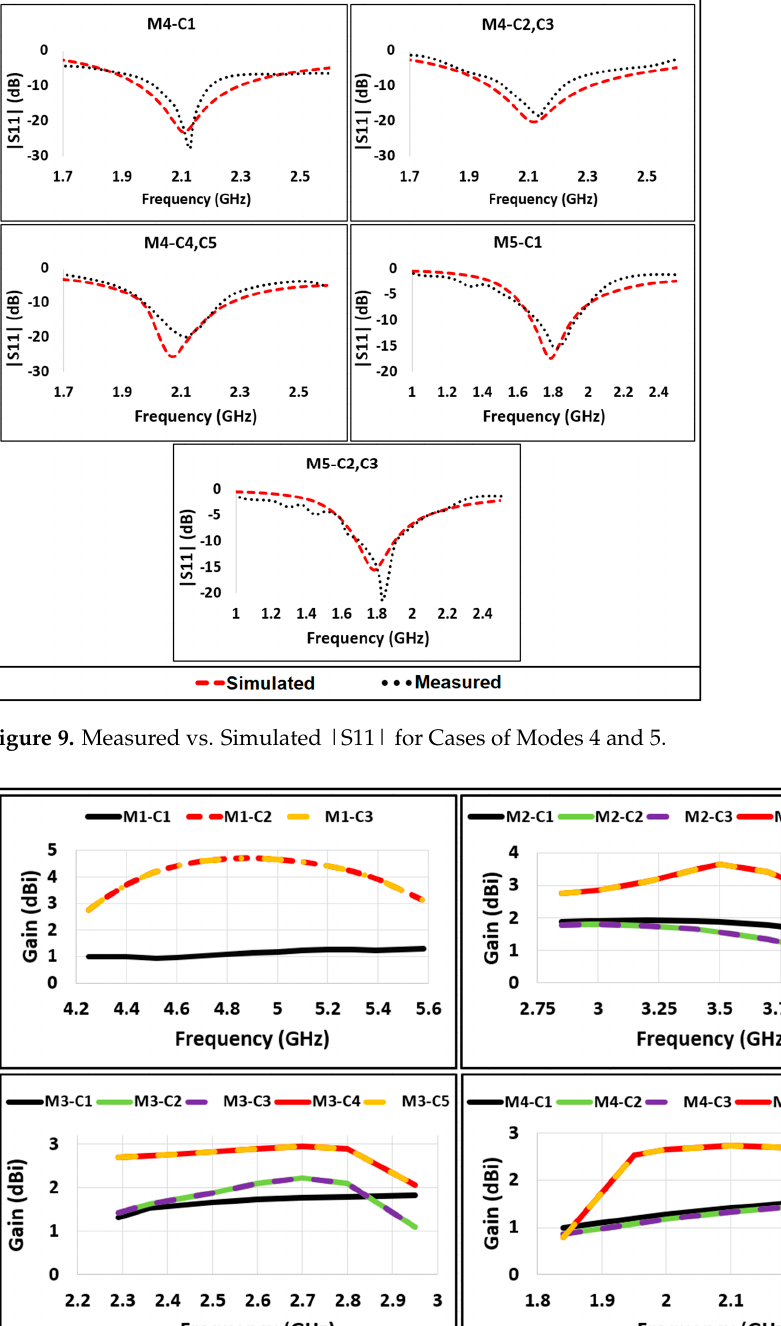
Figure 8. Measured vs Simulated |S11| for Cases of Mode 3.